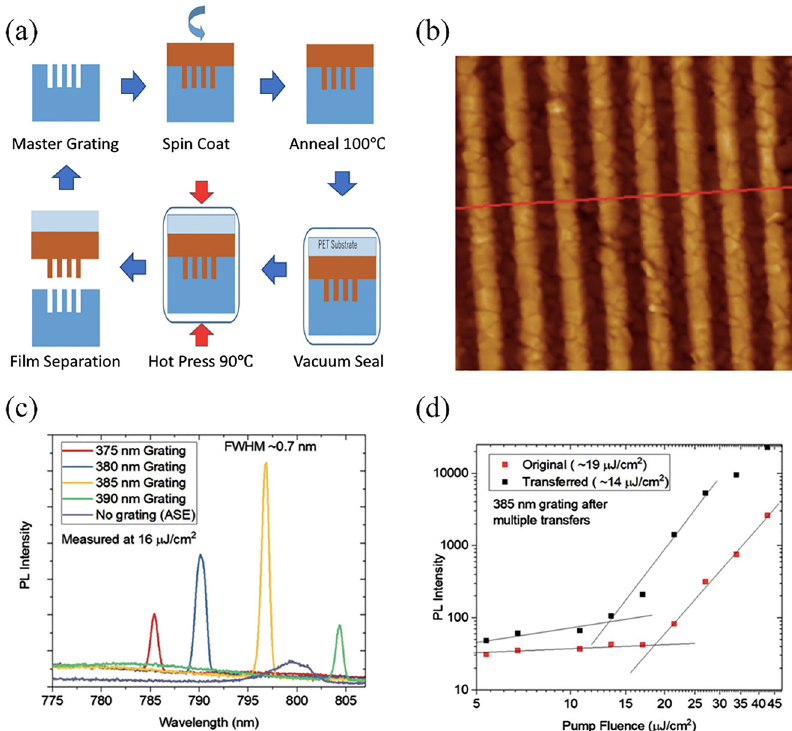
Figure 7: (a) The diagram of perovskite DFB films fabrication process. (b) Atomic force microscopy of a transferred perovskite DFB film. (c) PL spectra of perovskite DFB films with different transferred